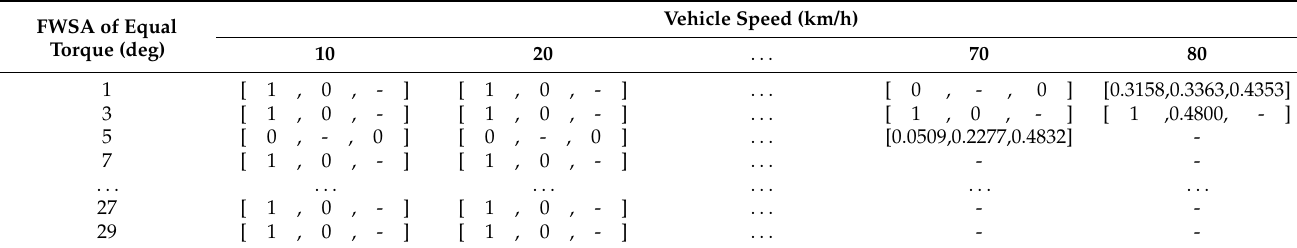
Table 3. Torque distribution coefficient based on working point at 10 km/h–80 km/h.